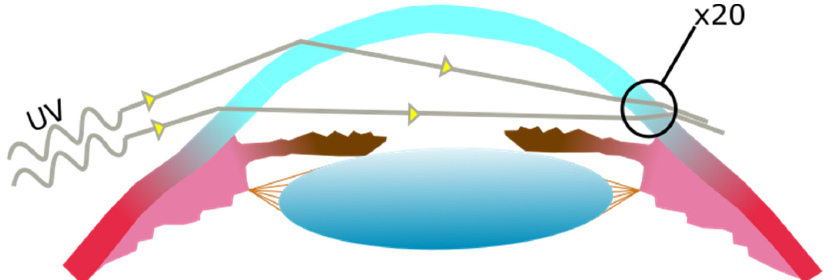
Figure 3. UV light entering the cornea laterally at the temporal side of the cornea, becoming focused at the nasal side of the cornea. The increase in UV exposure at the nasal side is estimated to be of up to twenty times the exposure on the temporal side. Table 1. UV damage and repair mechanisms in both skin and eyes.